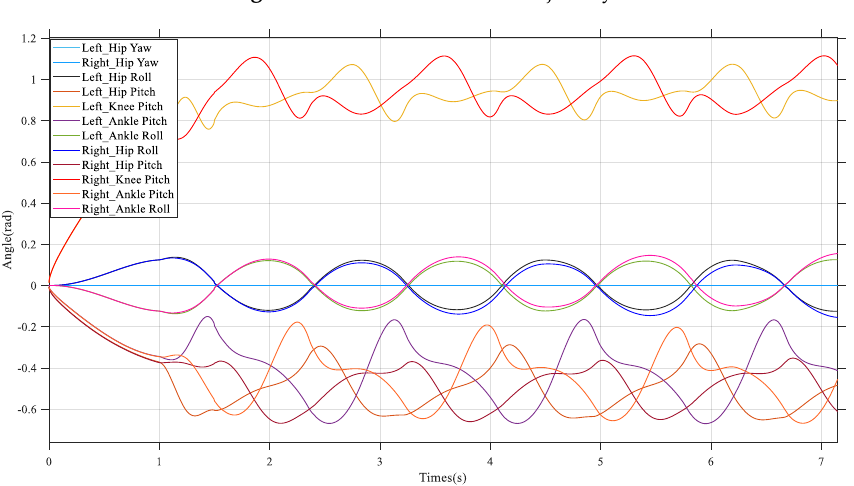
Figure 16. Each joint angle.